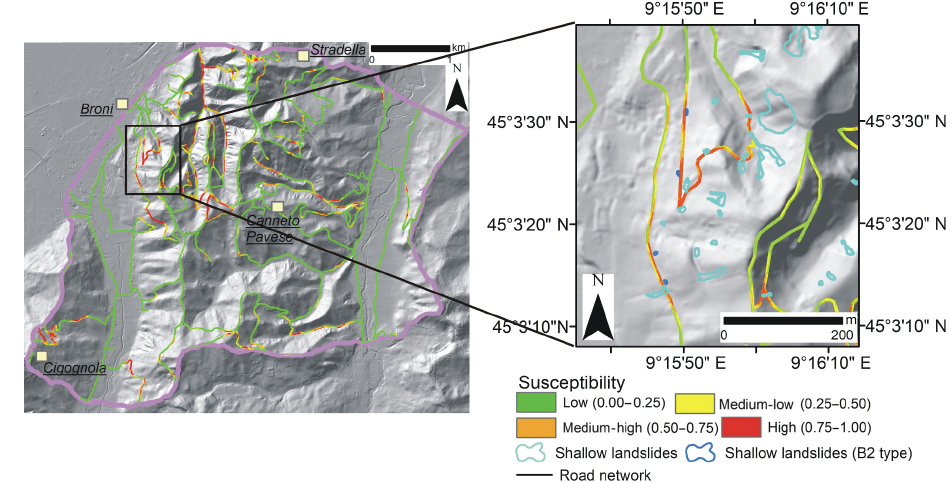
Figure 15. False positive (FP) cases identified through the susceptibility map obtained from Model 2. FP cases are mostly located close (in a range lower than 250m) to road sectors already affected by shallow landslides, in similar morphological and connectivity